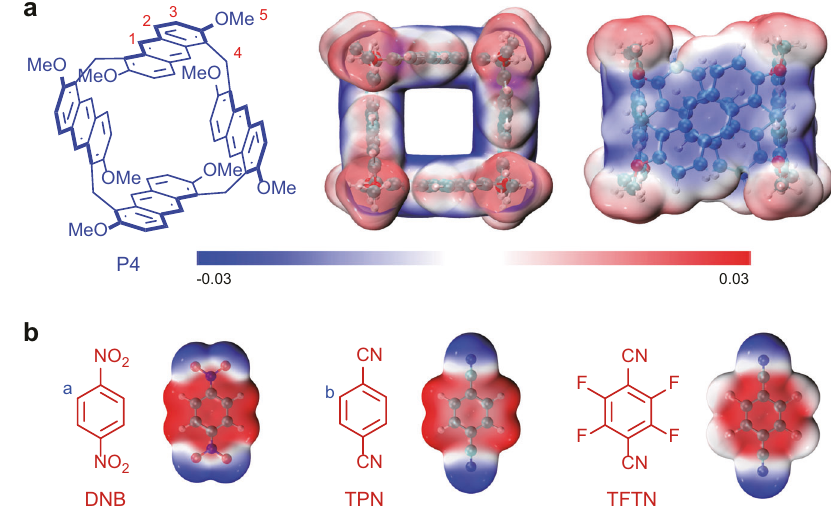
Fig. 2 Chemical structures and electrostatic potential maps. Chemical structures and electrostatic potential maps of a P4 and b guests DNB, TPN, and TFTN as building blocks for the design of supramolecular tessellations.